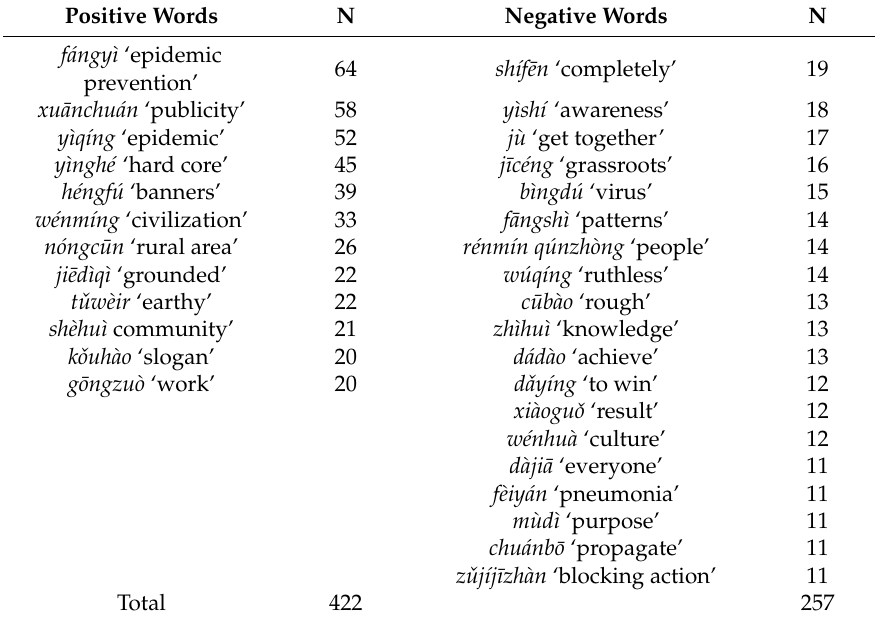
Table 9. Words with frequencies of 10 and over that were used in the banner comments; N = 679. Positive Words N Negative